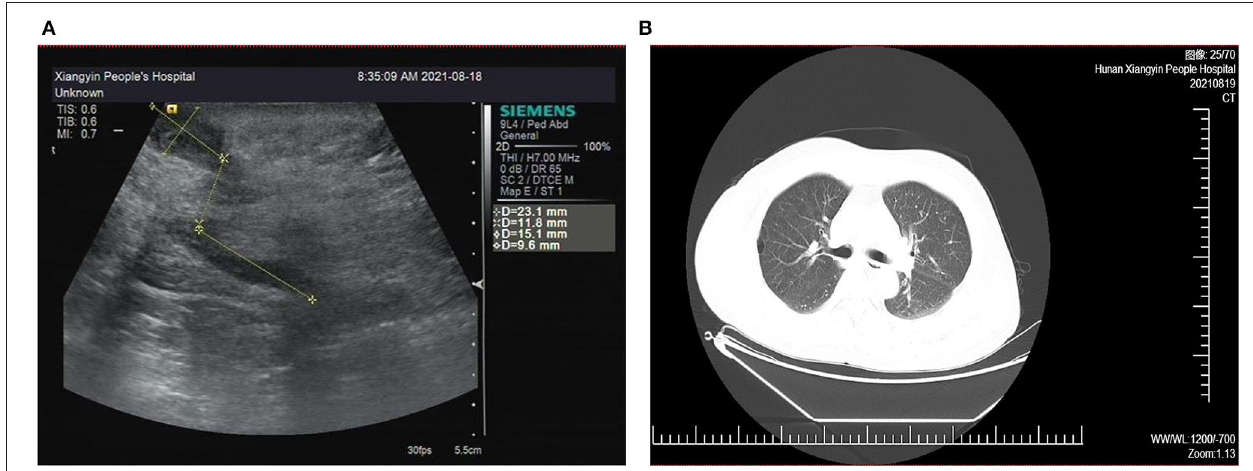
FIGURE 2 | (A) Abdominal B-ultrasound results show the formation of sinus tract and empyema. (B) Chest computed tomography images of the lung window show no sign of tuberculosis-related